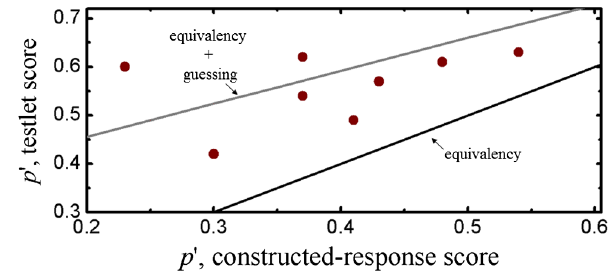
FIG. 2. A comparison of item difficulty parameter p 0 for each matching pair of constructed response and integrated testlet questions. The solid line labeled equivalency represents the expected relationship between questions of equal difficulty. Similarly, the solid line labeled equivalency þ guessing repre- sents the case of equivalent difficulty where those students who do not know the answer choose to guess. Note that the majority of data points lie between these two